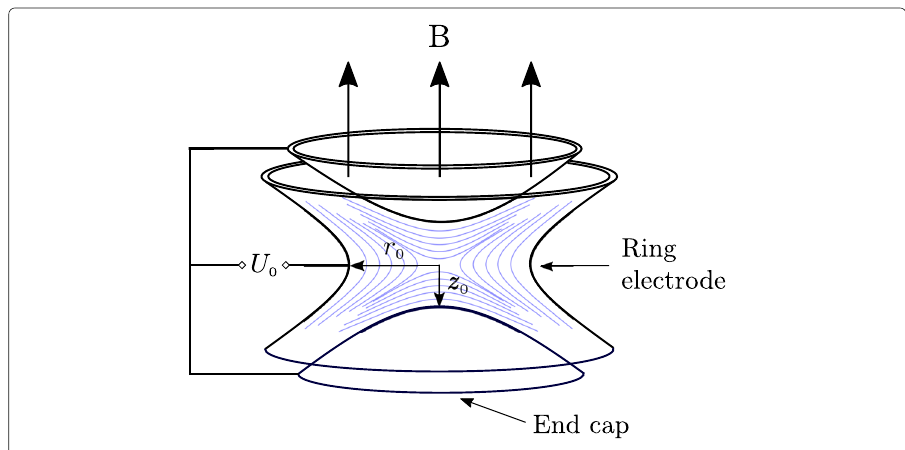
Fig. 1 Quadrupole penning trap, where r 0 = 7 mm and z 0 = 5 mm